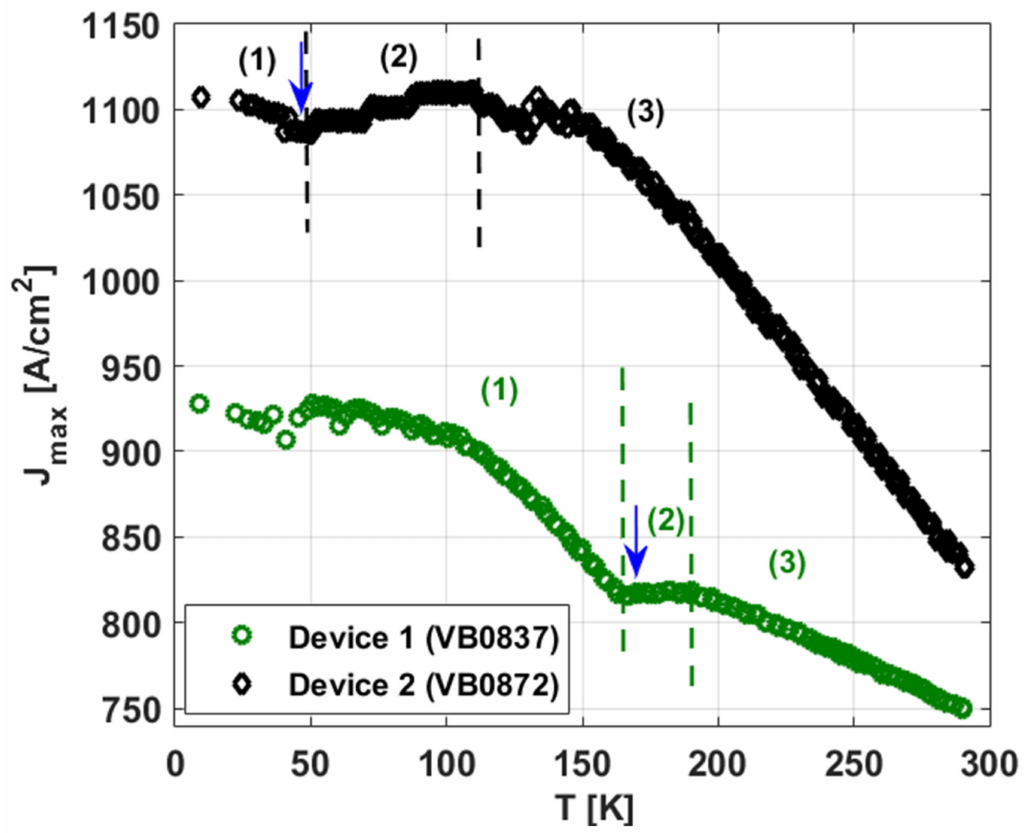
Figure 5. Maximum current versus temperature for the SW–DP THz QCL. Green circles refer to Device 1 (VB0837, 1 × doping) and black diamonds refer to Device 2 (VB0872, 2 × doping). For each device, three regions of interest (Regions 1, 2, and 3, defined in the text and marked in the figure) and the T max value (blue arrow) are